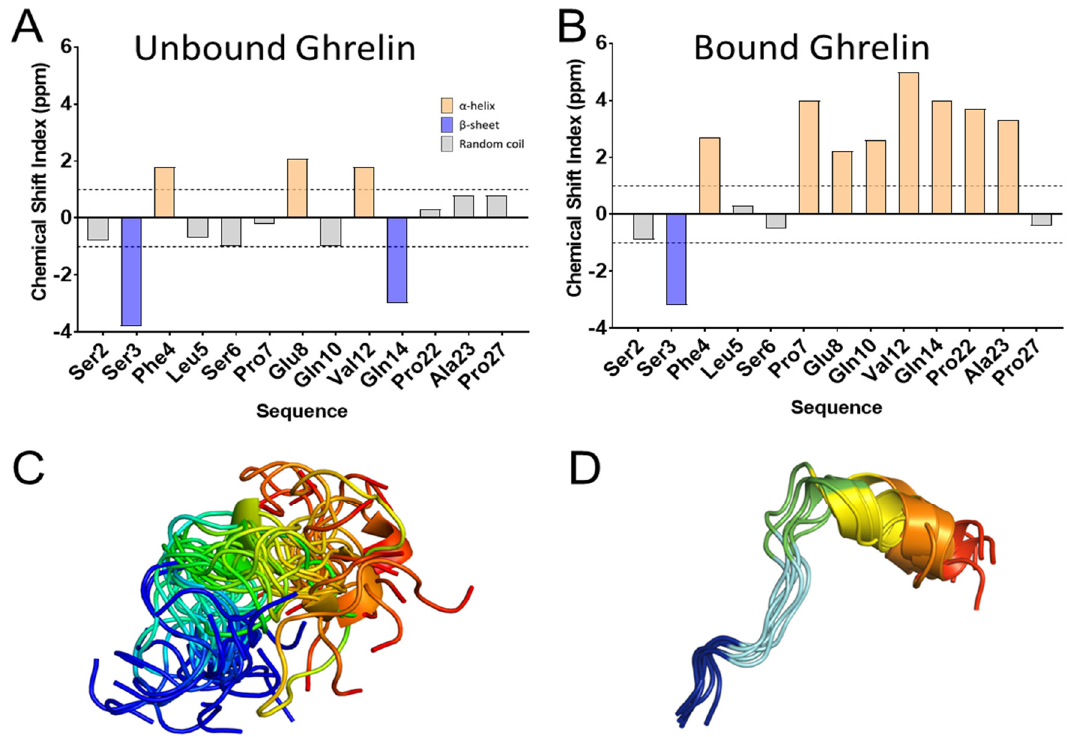
Figure 9. NMR measured conformational change in ghrelin upon the binding receptor. ( A , B ) Chemical shift index measurements of select residues in the ghrelin peptide in the presence of empty membrane or membrane containing ghrelin receptor [72,124]. These measurements identify a degree of secondary structure formation in the presence of receptor. ( C , D ) The chemical shifts were used to build models of ghrelin peptide in its two states, colored blue to red from N- to C-terminus.